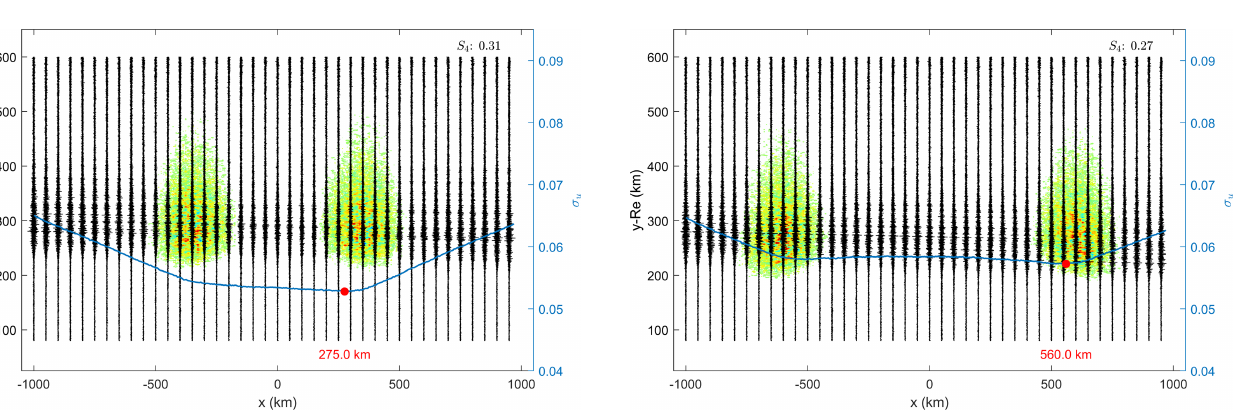
Figure 12. Bubbles at x 1 = − 600 and x 2 = 600km; σ (cid:49)ρ/ρ = 17%. Estimation error ε x 2 = 40km. Note the indication of the inbound bubble’s placement along the ray